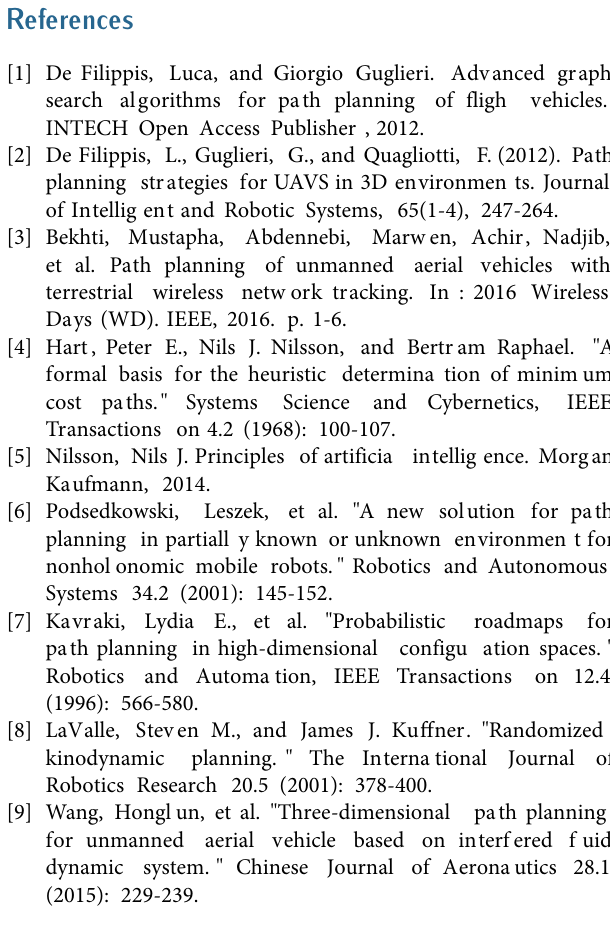
Figure 17. Energy consumption at different drone speeds